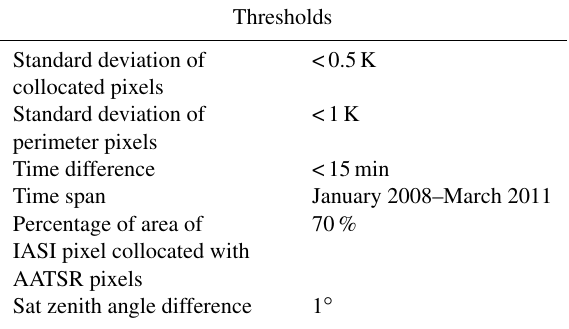
Table 1. Thresholds applied on collocated AATSR pixels in a single IASI